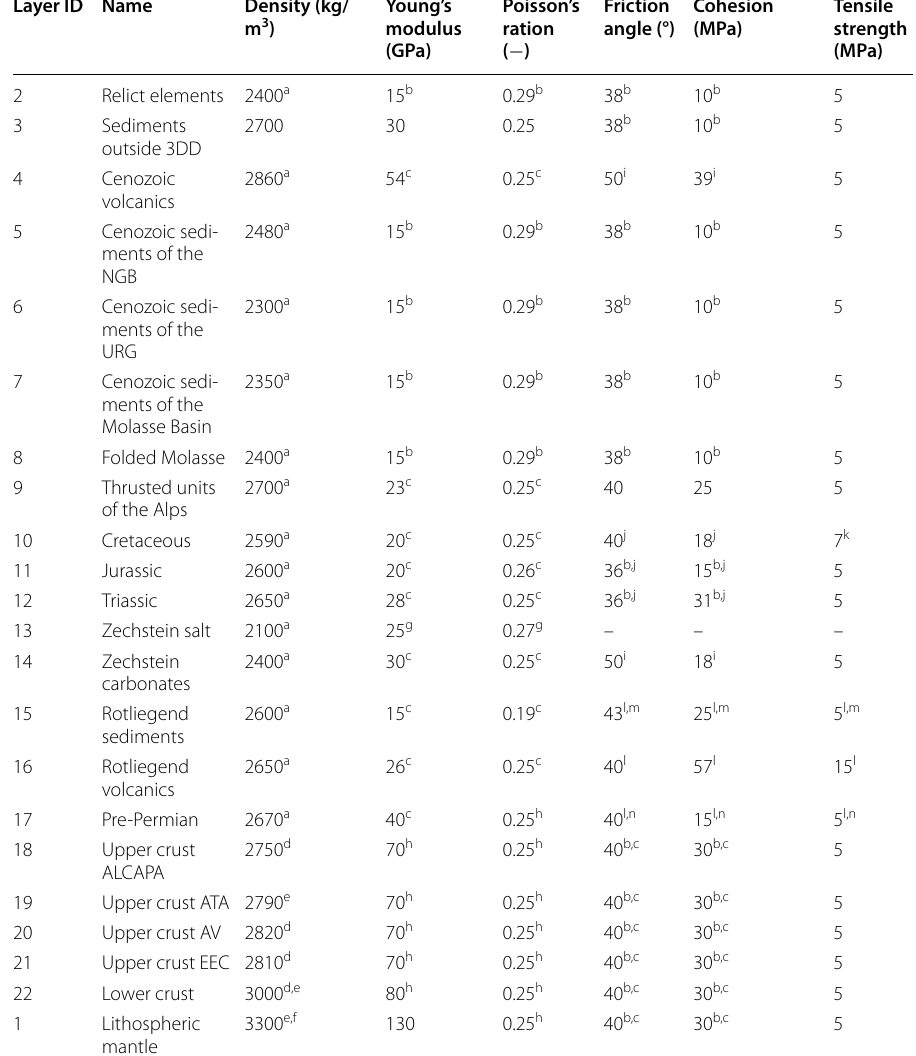
Table 1 Overview of all units defined in the model and parameters